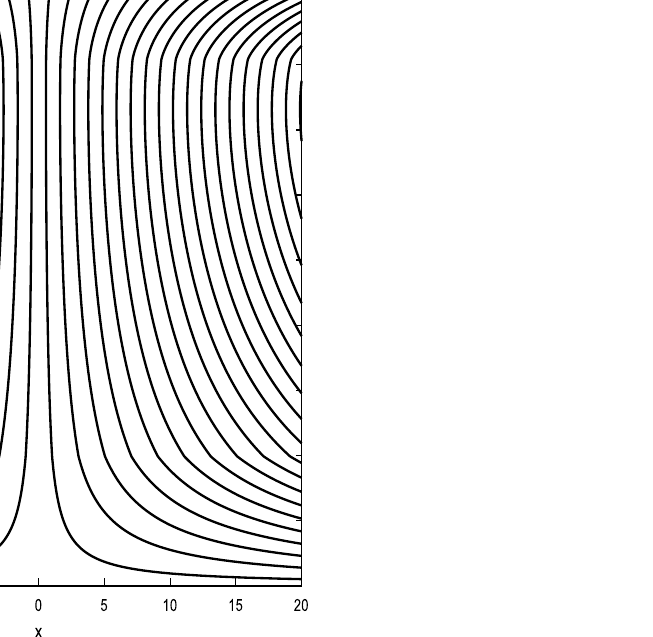
Figure 40. Stream lines profile at F = 0.6 and Ω = 0.5.